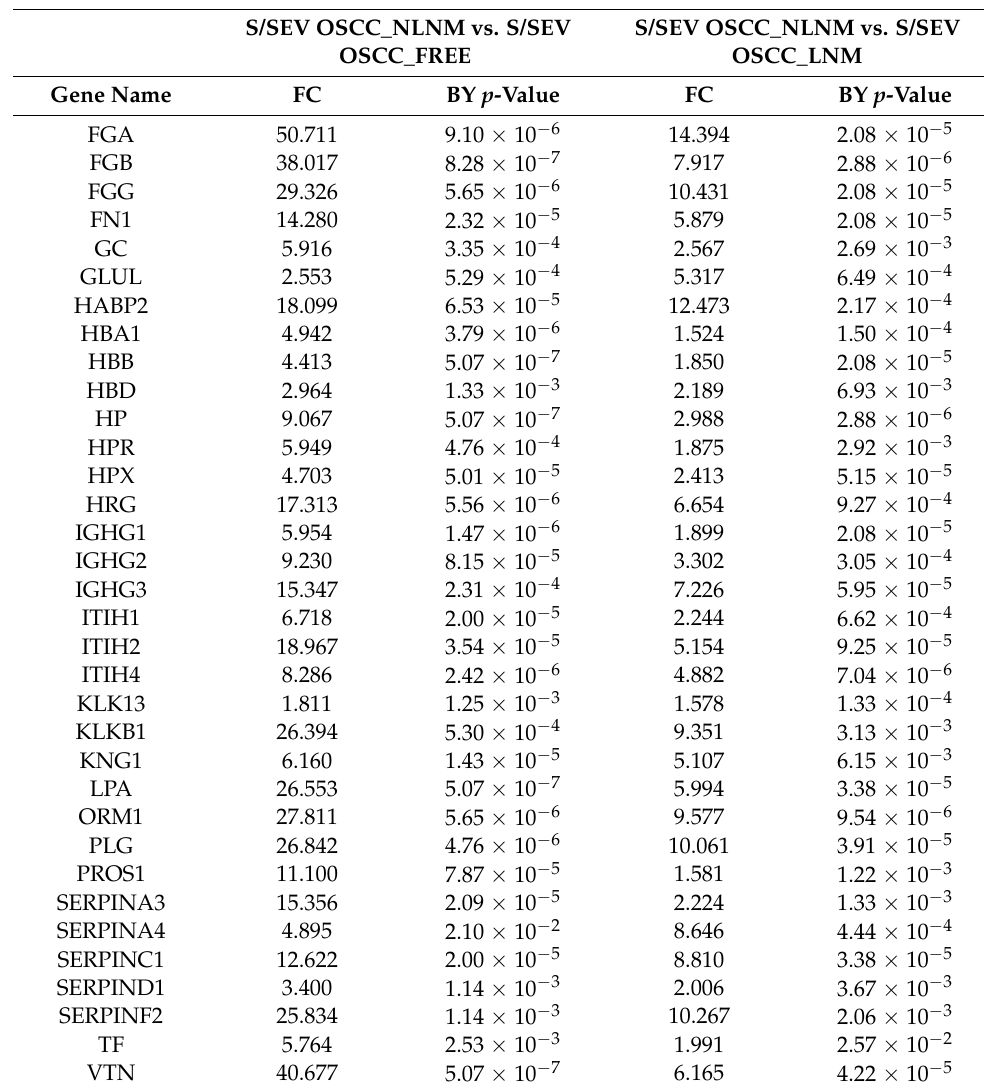
Table 6. Cont . PROTEINS UP-REPRESENTED in S/SEV OSCC_NLNM vs.